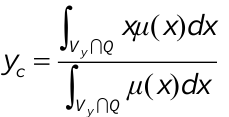
Figure 1. Rasterized centroidal Voronoi polygons for different number of generating points, N P =[100, 800, 1500,